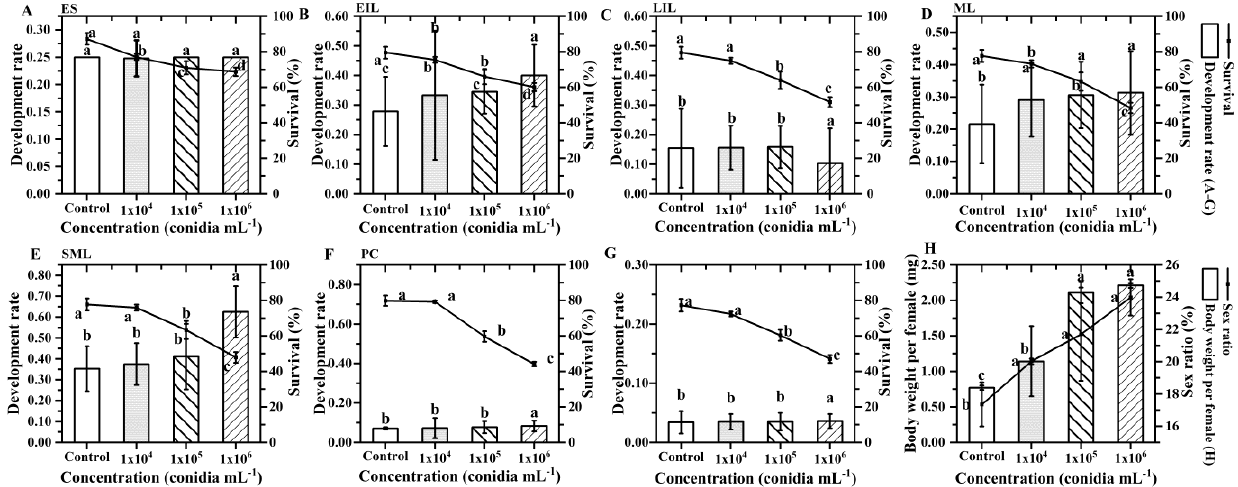
Figure 7 . The performance of immature offspring of S. guani under different concentrations of B. bassiana spore suspensions. The mean development rate and survival rate of immature offspring of S. guani . ( A ) ES: egg of S. guani ; ( B ) EIL: early instar larval; ( C ) LIL: late instar larval; ( D ) ML: mature larval; ( E ) SML: spanning mature larval; ( F ) PC: pupa cocoon; ( G ) whole generation and survival of the offspring of S. guani ; ( H ) sex ratio and body weight per female of the offspring of S. guani . Different letters above the bars indicate significant differences (mean ± SE, n = 30 in each treatment, p < 0.05).